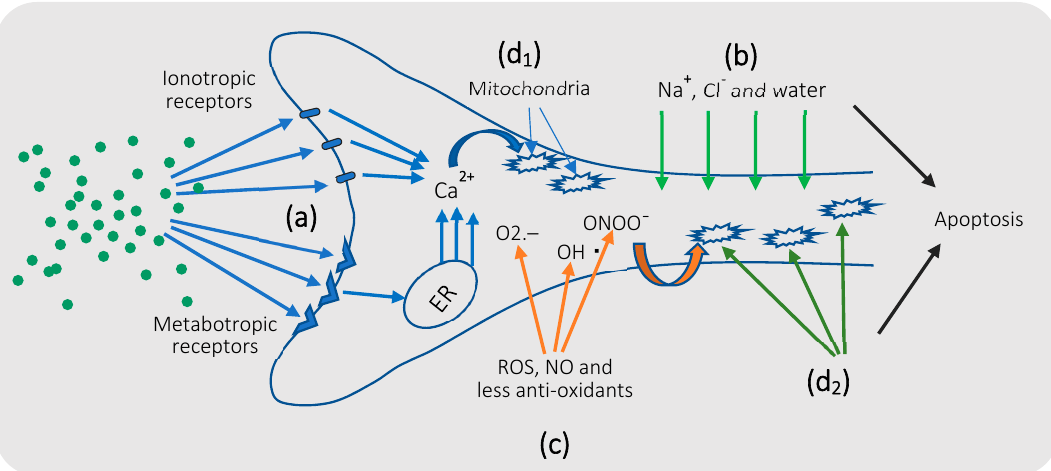
Figure 3. Molecular mechanisms of glutamate excitotoxicity: ( a ) Glutamatergic receptor hyperactivation: Excess extracellular glutamate overstimulates ionotropic (NMDA, AMPA, or KA) and metabotropic (type I and V) receptors in neurons, inducing intracellular Ca 2+ entry through ionic channels and Ca 2+ release from the ER, respectively. This raised intracellular Ca 2+ level represents the first signal for apoptosis; ( b ) excessive ion influx: NMDA receptor hyperstimulation triggers rapid influx of Na + , Cl - , and water into neurons, resulting in acute rupture of the cell membrane; ( c ) oxidative stress: Excessive production of ROS and NO, and reduced antioxidant mechanisms in neurodegenerative diseases, induce damage to the cellular nucleic acid and intracellular molecules and, eventually, triggers neuronal cell death; ( d ) mitochondrial dysfunction: Overstimulation by elevated [Ca 2+ ] i concentration ( d 1 ) and oxidative stress ( d 2 ) trigger the opening of mitochondrial transition pores and release of apoptotic factors to the cytoplasm, which, finally, results in neuronal apoptosis.